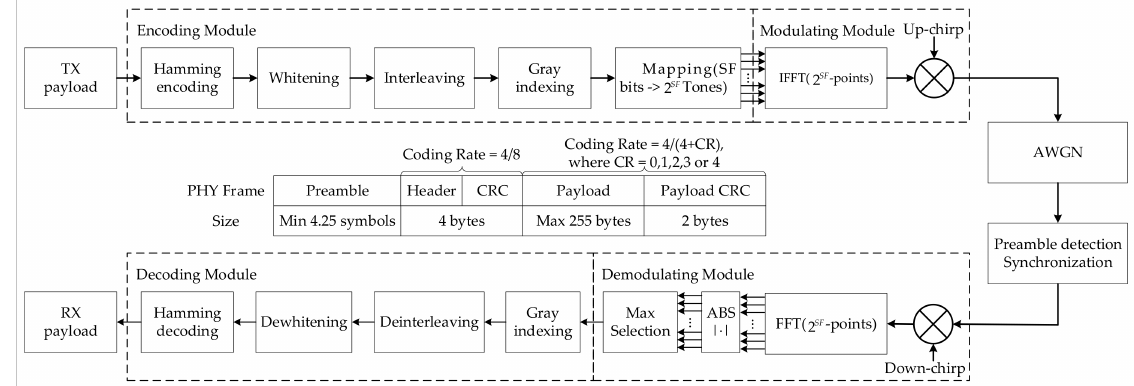
Figure 2. System model of the LoRa physical layer.